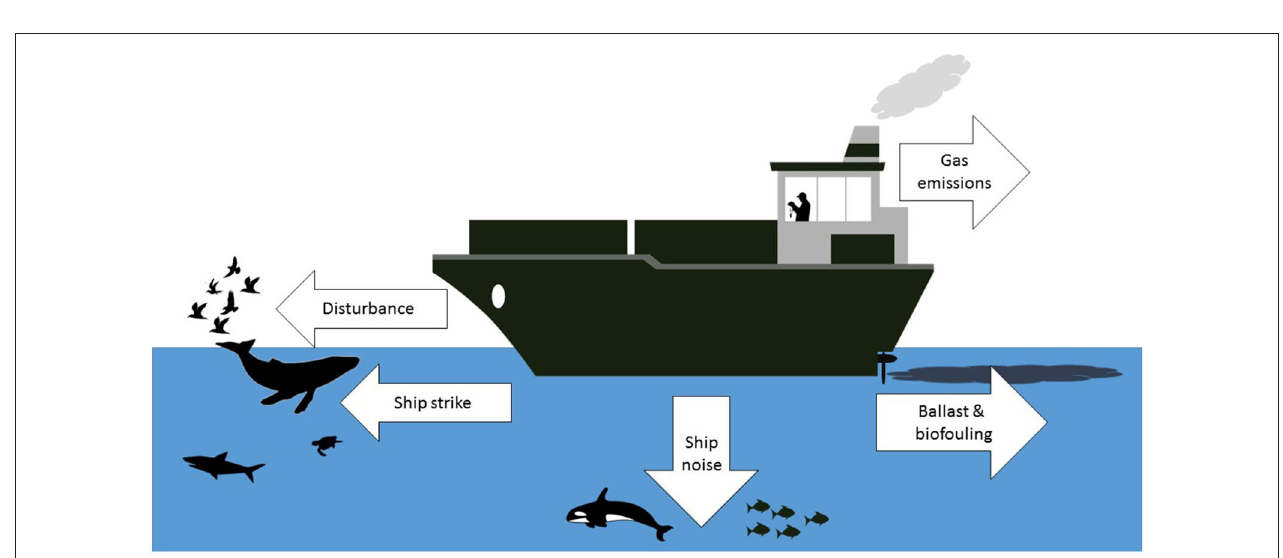
FIGURE 2 | Infographic on the potential impacts of shipping addressed in this special issue: ship strike (Arregui et al.; Calambokidis et al.; Aschettino et al.; Cloyed et al.; Flynn and Calambokidis; Gende et al.; Greig et al.; Keen et al.; Leaper; Peltier et al.; Redfern et al.; Schoeman et al.; Szesciorka et al.; Silber and Adams; Smith et al.), ship noise (Chion et al.; Erbe, Dähne et al.; Erbe, Marley et al.; Heenehan et al.; Joy et al.; Leaper; Silber and Adams), gas emission (Leaper; Silber and Adams), chemical spill (Silber and Adams), introduced pests (Hayes et al.), and induced flushing (i.e., seabird disturbance, Fliessbach et